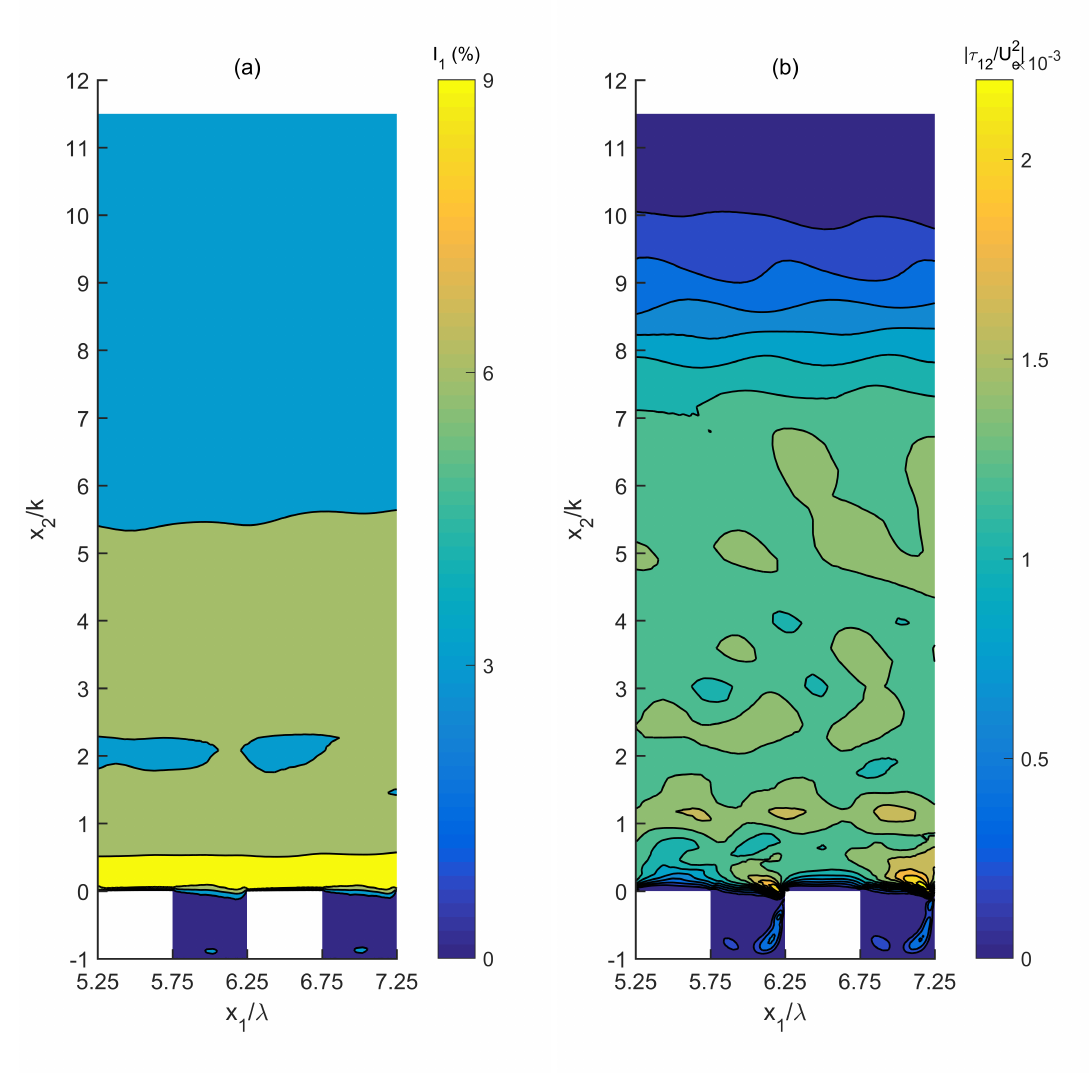
Figure 9. Vertical planes (at x 3 = 0.0375 m) showing predicted distributions of: ( a ) relative turbulence intensity component I 1 in the streamwise direction; ( b ) specific Reynold shear stress − u (cid:48) by the freestream velocity squared U 2 e . The distributions are from LES outputs for Run